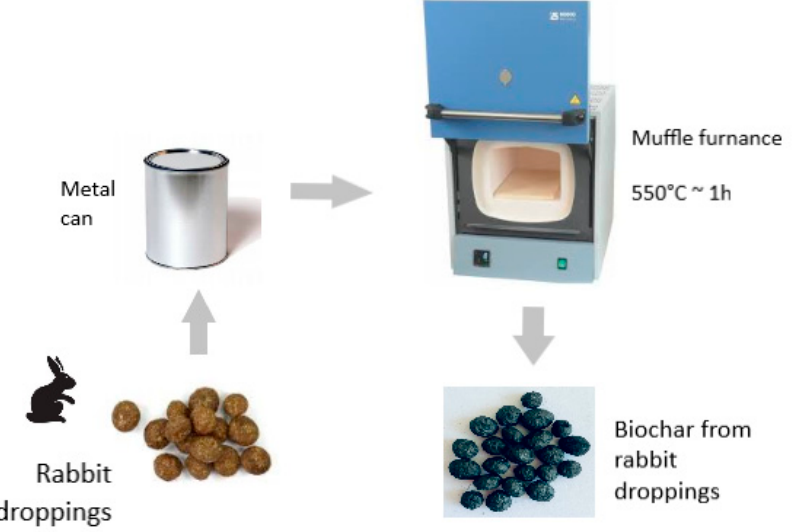
Figure 1. Scheme of rabbit-manure-derived biochar production.